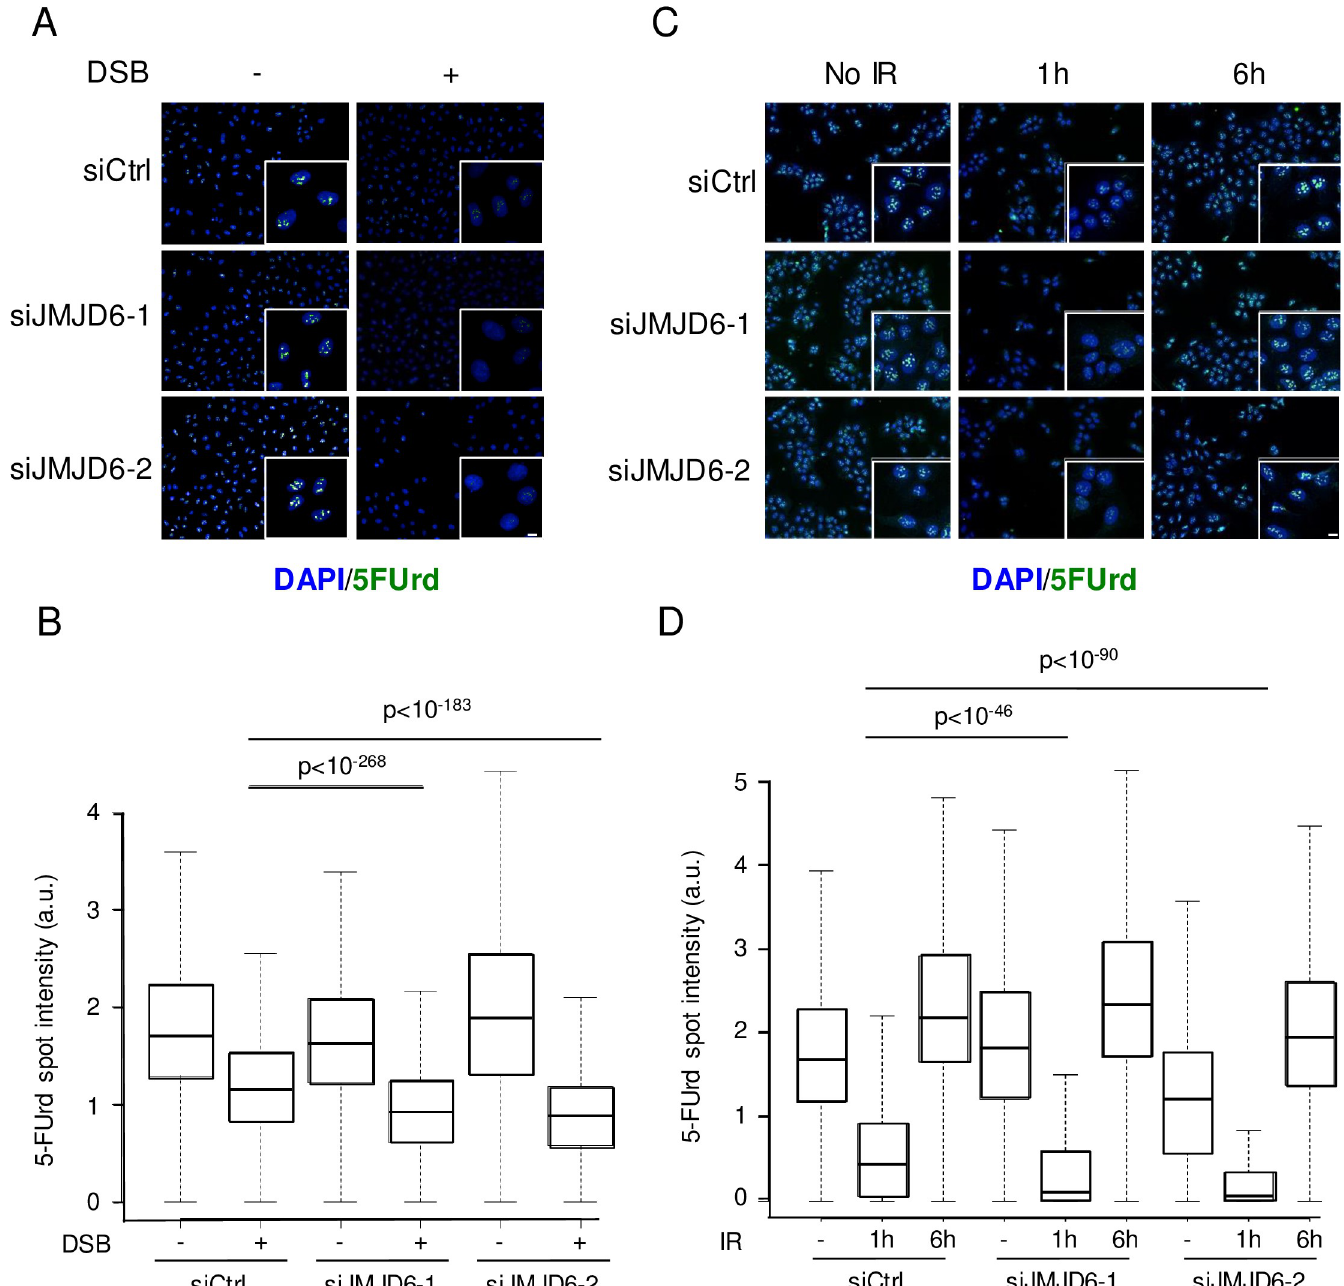
Fig 7. JMJD6 expression favours rDNA transcription following DNA damage. (A) Level of rDNA transcription assessed through 5FUrd incorporation following 4 hours of endonuclease-mediated DSBs (AsiSI) in U2OS DIVA cells transfected with the indicated siRNA, insert: a magnified region of the image. Scale bar 5 μ m. (B) Quantification of 5FUrd staining by high throughput microscopy in cells from A. A representative experiment from 2 independent experiments is shown. The p values of the difference between the indicated samples are shown (Wilcoxon test). (C) Same as in A, except that cells were exposed to ionizing radiation (IR) (8 Gy) or not and stained 1 hour or 6 hours following irradiation. Scale bar 5 μ m. (D) Quantification of 5FUrd staining by high throughput microscopy in cells from C. A representative experiment from 2 independent experiments is shown. For each data point a minimum of 200 cells were quantified. The p values of the difference between the indicated samples are indicated (Wilcoxon